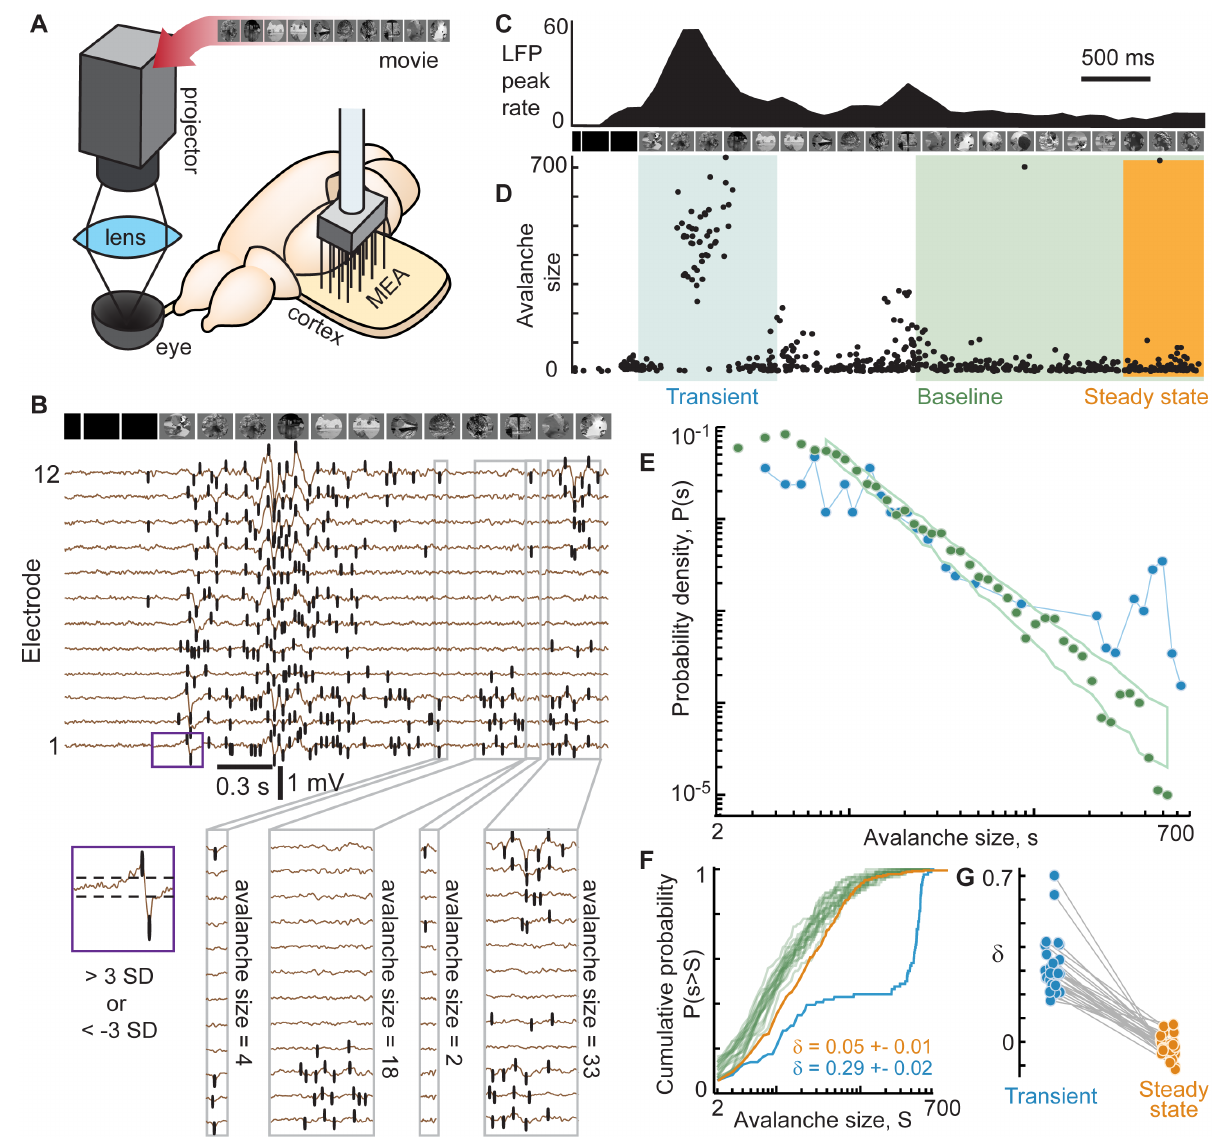
Fig 2. Adaptation tunes cortical dynamics from large-scale transient response to scale-freesteady-state. ( A ) Motion-enhanced movies were projectedonto the retina whilerecordinglocal field potential (LFP) with a microelectrode array in visual cortex of the turtle ex vivo eye-attached whole-brainpreparation. ( B ) Shownare LFP traces from a subset of 12 electrodes. Intense population activity occurs at the onset of the movie; adaptation leads to more moderate steady-state activity. To characterize these changesin populationactivity, we analyze‘avalanches’ which are definedas spatiotemporal clusters of LFP peaks beyond ± 3 SD (black ticks). Avalanche size was definedas the numberof LFP peaks comprisingthe cluster. ( C ) LFP peak rate time series, averagedover 80 movie repetitions. ( D ) Each point representsthe size and time (middle of duration) of one avalanche. Avalanches from 80 trials are overlaid. Avalanches were typicallyvery large duringthe transient response, but adaptation resulted in smaller and more diversesizes. ( E ) Typical distributionsof avalanchesizes duringthe transient (blue, 0–1 s after movie onset) and the baselineperiod(green, 2–5 s after movie onset). During the transient, the distributionexhibiteda ‘bump’ at large size indicating a high likelihoodof very large avalanches. During baseline, avalanchesize distributionswere well-described by a power-lawfunction, in line with recent findings that adaptation tunes cortical network dynamicsto criticality. Green box delineatesthe expectedrange (5–95 percentile)of probabilities for a finite sample drawn from a perfect power law. ( F ) To quantitatively characterize population dynamics duringdifferent time periods we computed δ , which measuresdeviationfrom the baselinedistribution. Calculationof δ is basedon differences betweencumulativedistributions like the examplesshown. ( G ) Shown is a summary of 14 experiments. Without exception,the transient exhibitedmany more large avalanches than the baseline( δ> 0) while the steady state period(4–5 s after movie onset) exhibitedsmall deviations, both positive and negative,from baseline.